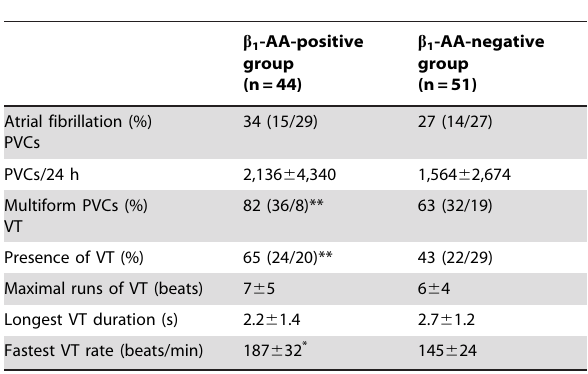
Table 2. Holter Electrocardiographic Findings (mean 6